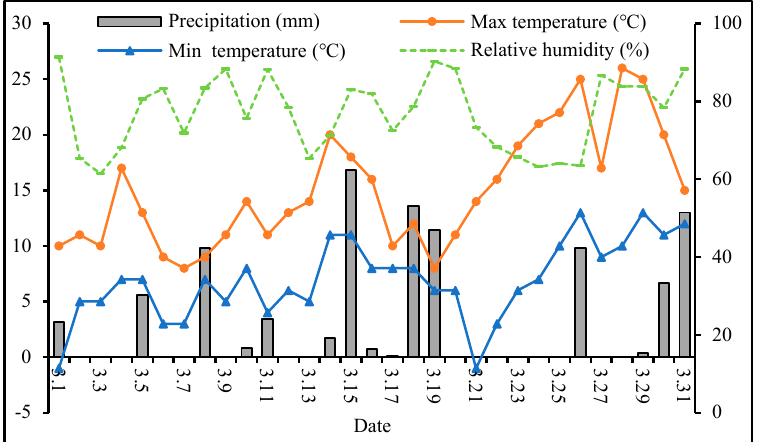
Figure 1. The weather conditions during March at anther differentiation period in the wheat-growing season (2020 − 2021).